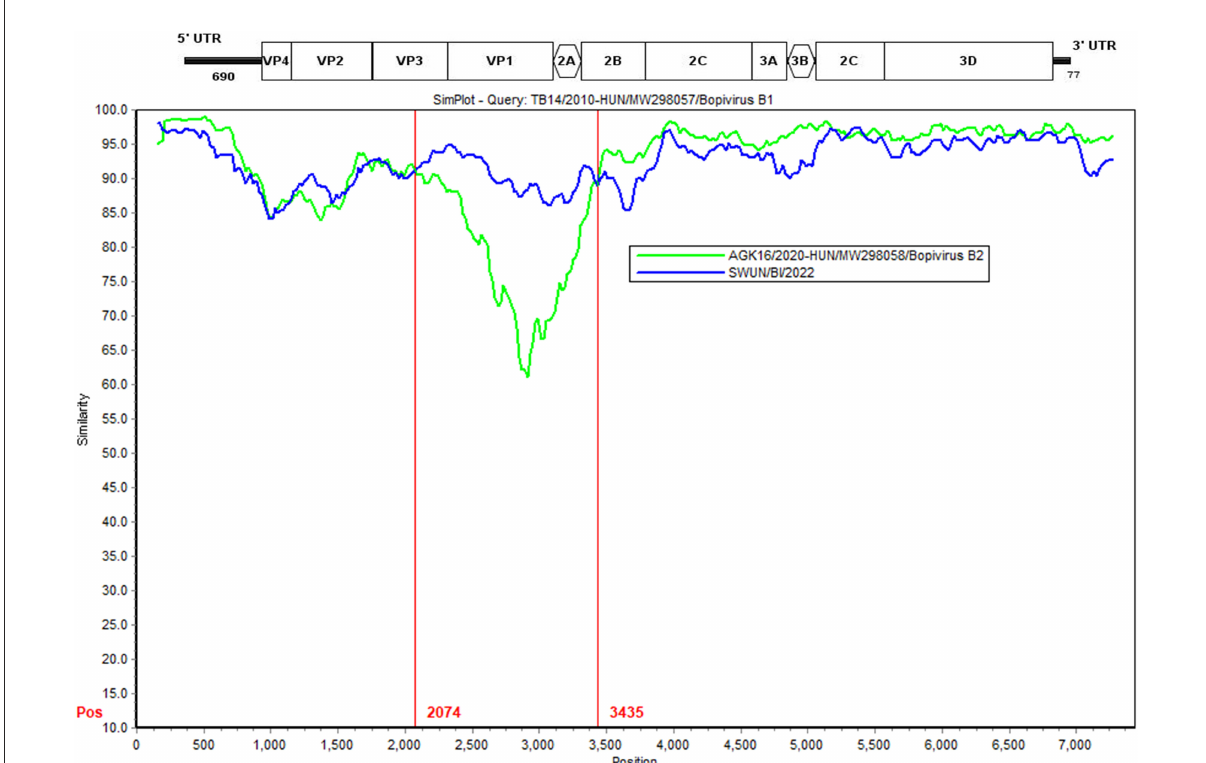
FIGURE5 Recombination analysis of the bopivirus strains using SimPlot 3.5.1. The bopivirus B1 strain ovine/TB14/2010-HUN (GenBank accession number MW298057) and the bopivirus B2 strain goat/AGK16/2020-HUN (GenBank accession number MW298058) are shown. The